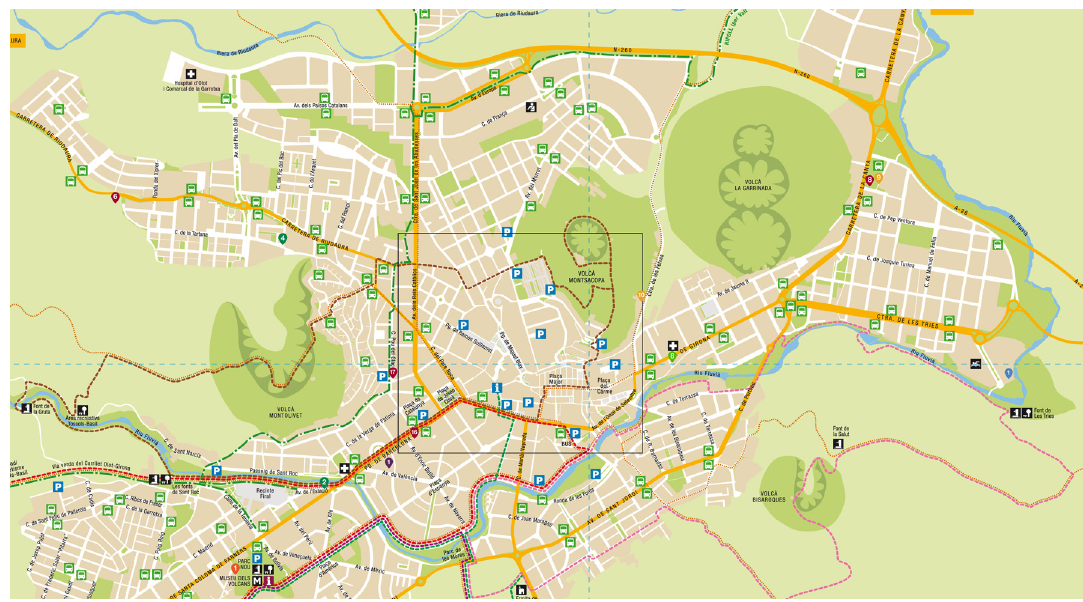
Figure 2: Map of Olot. Source: Associació la Garrotxa Terra d ’ Acollliment Turístic, Mapa Garrotxa ,